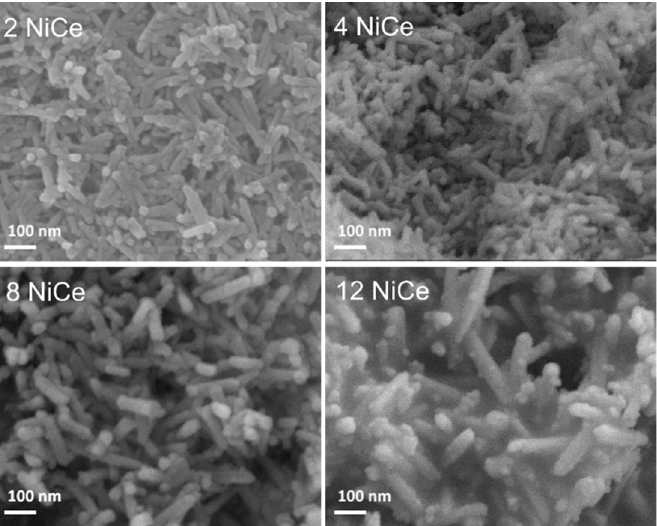
Figure 1. Field emission scanning electron microscopy (FE-SEM) images of the calcined NiCe samples.